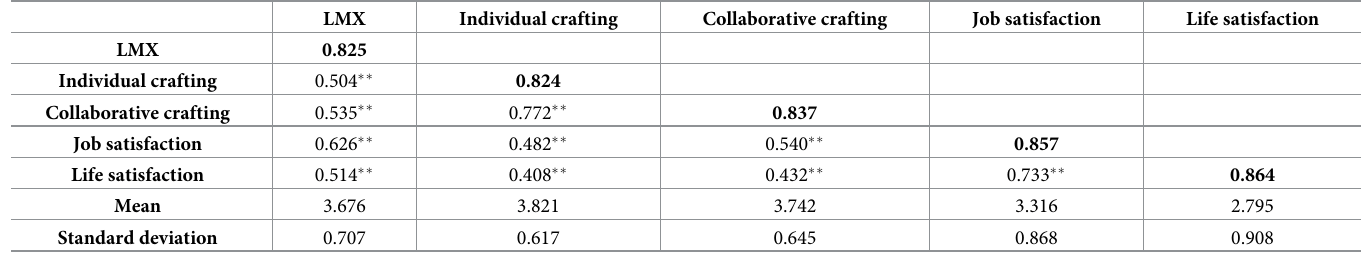
Table 2. Descriptive statistics and correlations of constructs and AVE